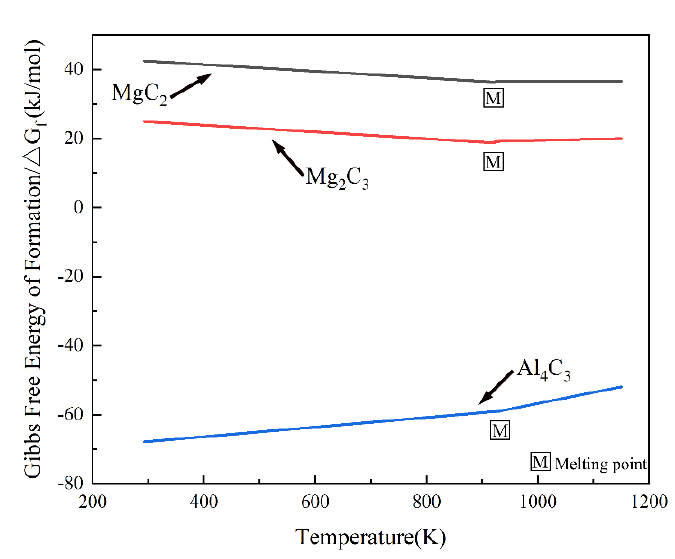
Figure 16. Gibbs free energy of formation of Al 4 C 3 , MgC 2 , and Mg 2 C 3 .